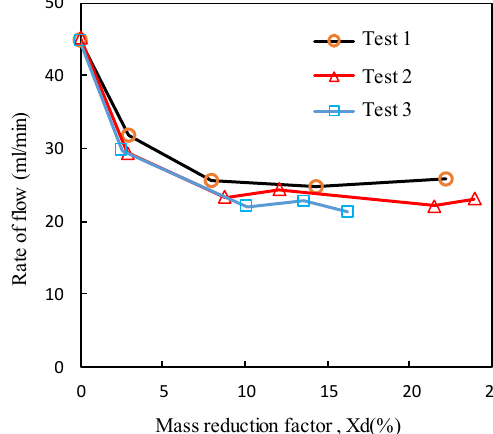
Fig. 1 . Flow variation with a mass reduction